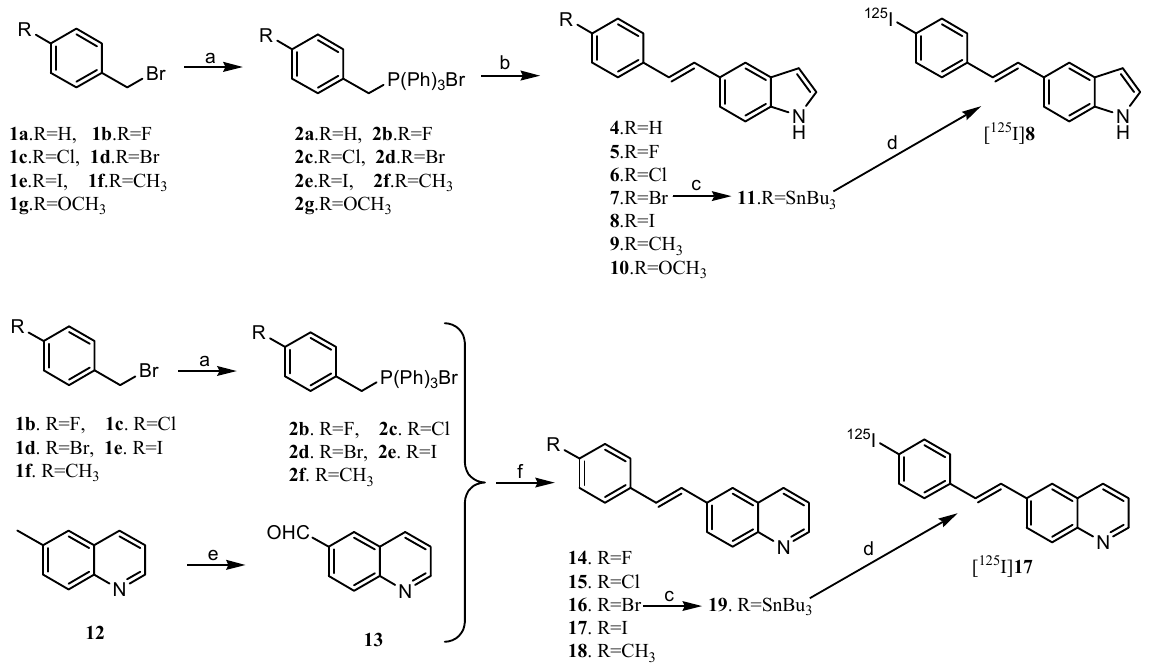
Scheme 1. Synthetic route of ( E )-5-styryl-1 H -indole and ( E )-6-Styrylquinoline